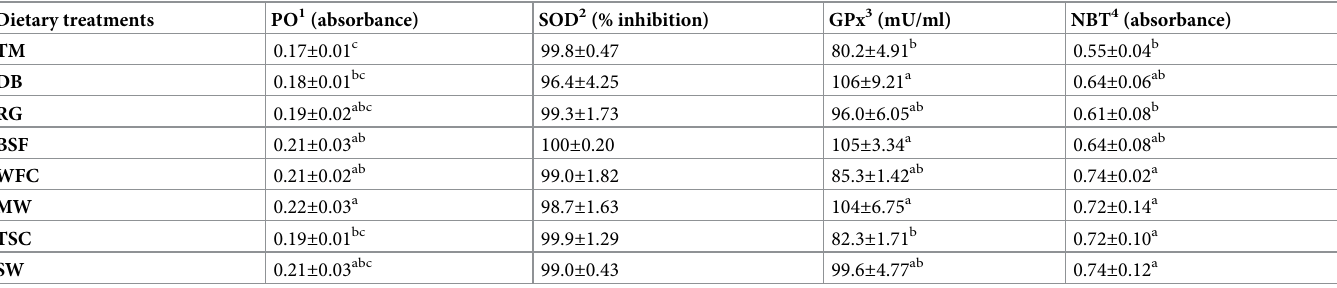
Values are mean of triplicates (n = 3) and presented as mean ± standard deviation. Different superscripts in each column indicate significant differences ( P < 0.05). Dietary treatments are abbreviated as: tuna byproduct meal (TM) as a fish meal, dynastid beetle (DB), rice grasshopper (RG), black soldier fly (BSF), white-spotted flower chafer (WFC), mealworm (MW), two-spotted cricket (TSC) and silkworm (SW).